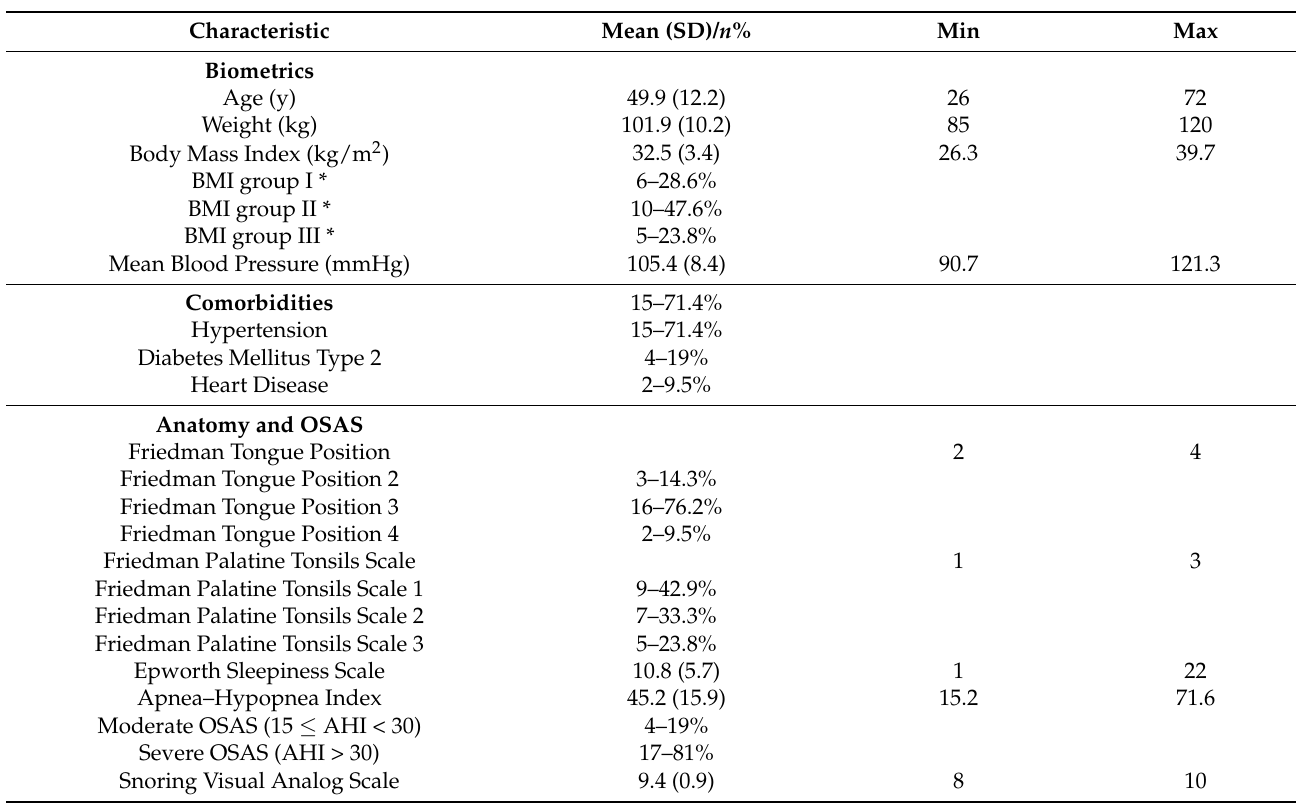
Table 1. Baseline characteristics of the study group ( n = 21 male